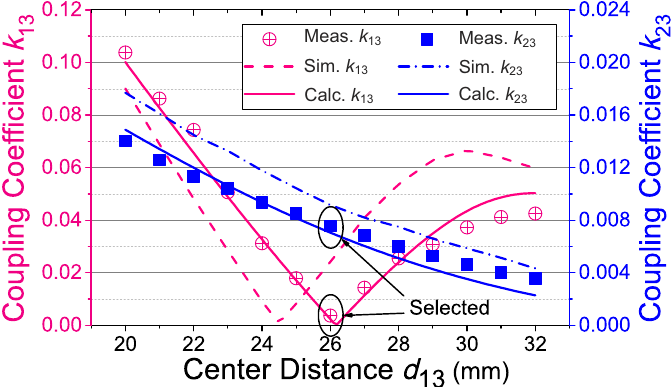
Figure 11. Measured (Meas.), simulated (Sim.) and calculated (Calc.) coupling coefficients ( k 13 , k 23 ) versus the center distance ( d 13 ), when the coil separation is d = 20 mm.